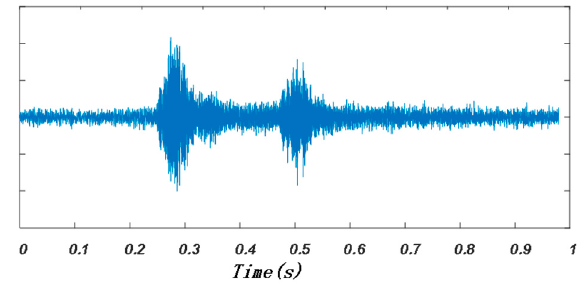
Figure 9. An example of the received audio signal during one positioning period.